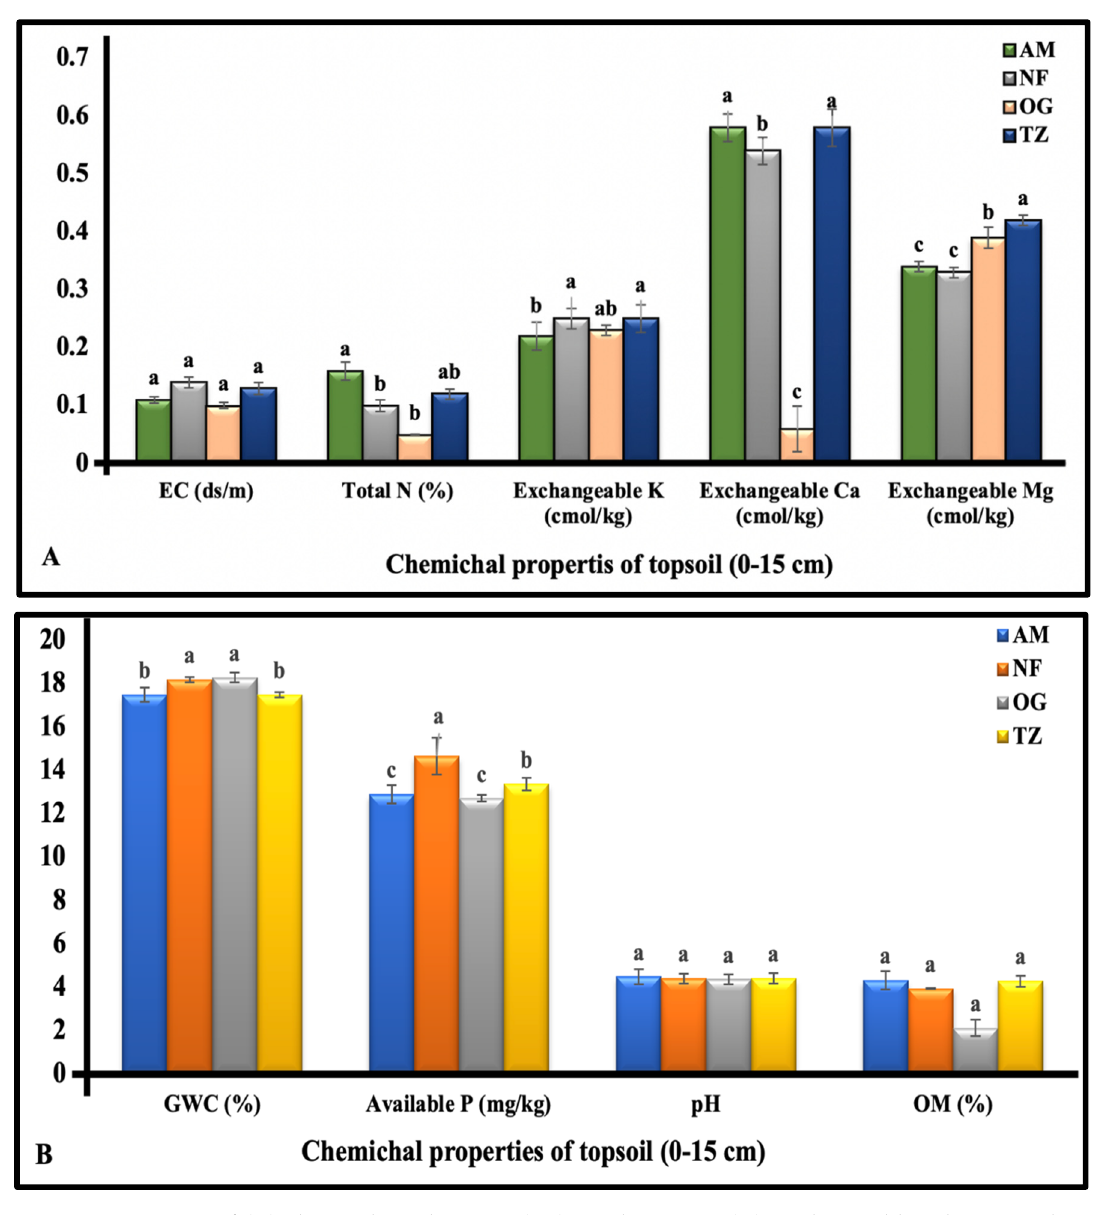
Figure 5. Measurements of ( A ) electrical conductivity (EC), total nitrogen (N), exchangeable calcium, exchangeable magnesium, and exchangeable potassium, and ( B ) gravitational water content, available phosphorus, pH, and organic matter of topsoil (0–15 cm depth) in Ayam Hiter forest of Malaysia across four different regions. Note: AM = Acacia mangium region, TZ = Transition region, OG = Open ground region, NF = Native Forest region. Distinct letters imply significant distinctions between arsenic concentrations following Duncan’s multiple comparison test ( p ≤ 0.01).